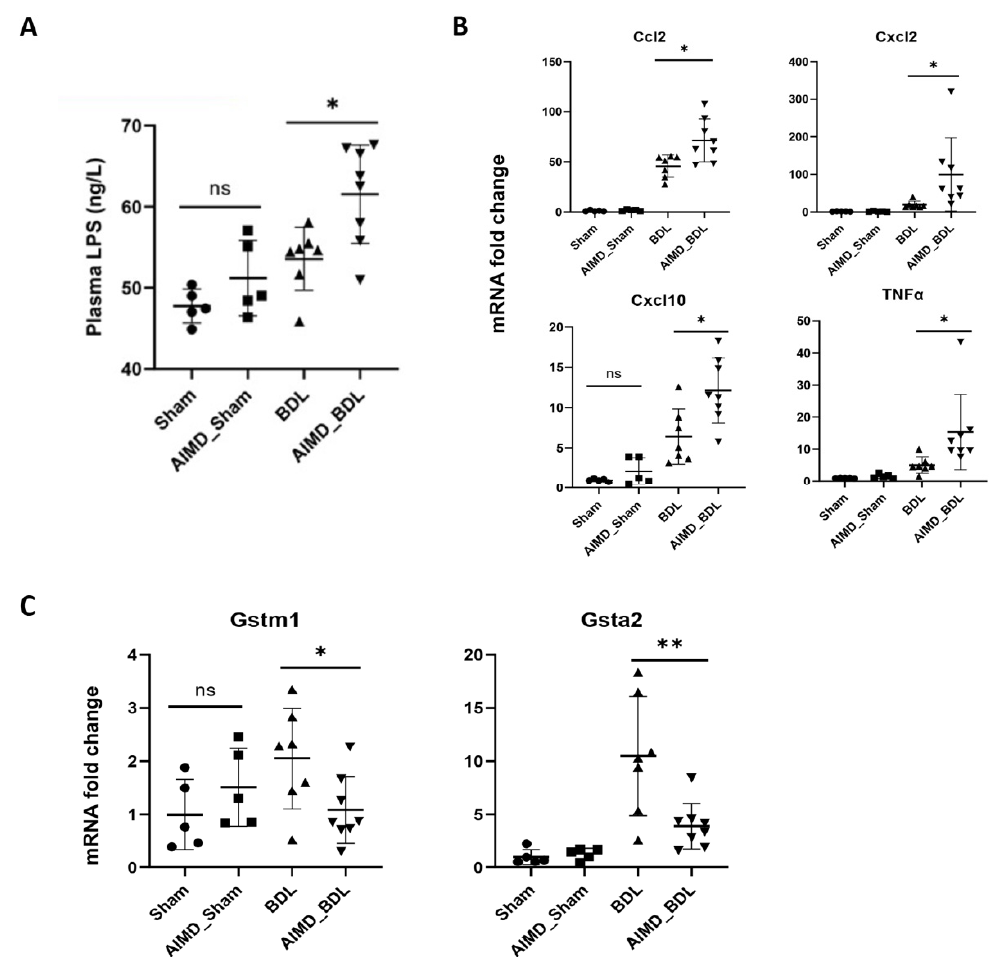
Figure 7. ( A ) The plasma levels of LPS in each group. ( B ) The expression of proinflammatory cytokines in the liver of each group. ( C ) The expression of glutathione transferases in the liver of each group. Sham, n = 5; AIMD_Sham, n = 5; BDL, n = 7; AIMD_BDL groups, n = 8. * p < 0.05; ** p < 0.01; ns, no significance.